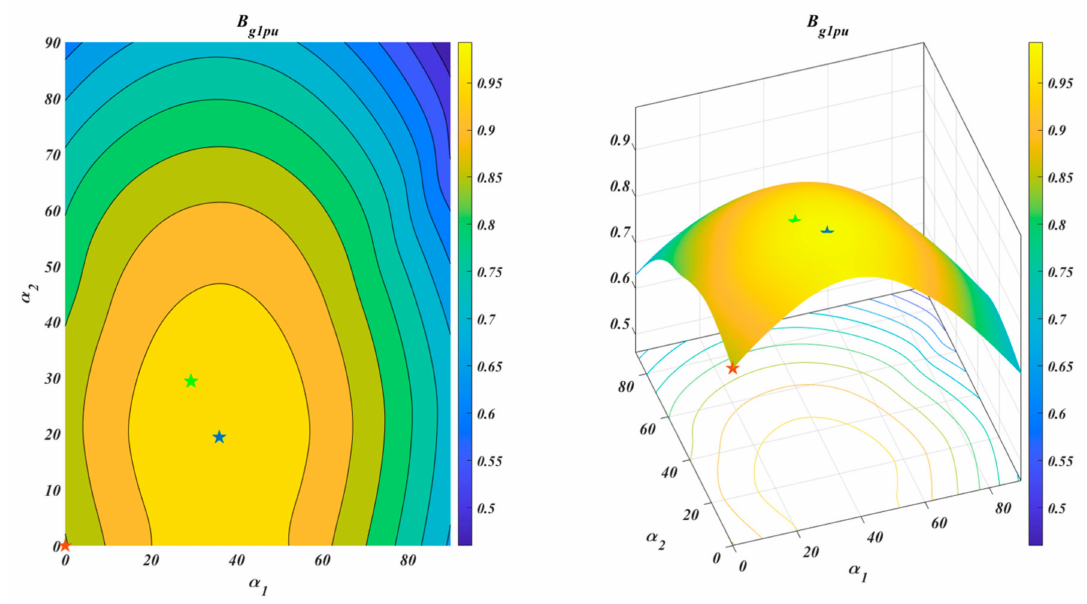
Figure 8. Peak fundamental harmonic air gap flux density for 0 ◦ to 90 ◦ tilt